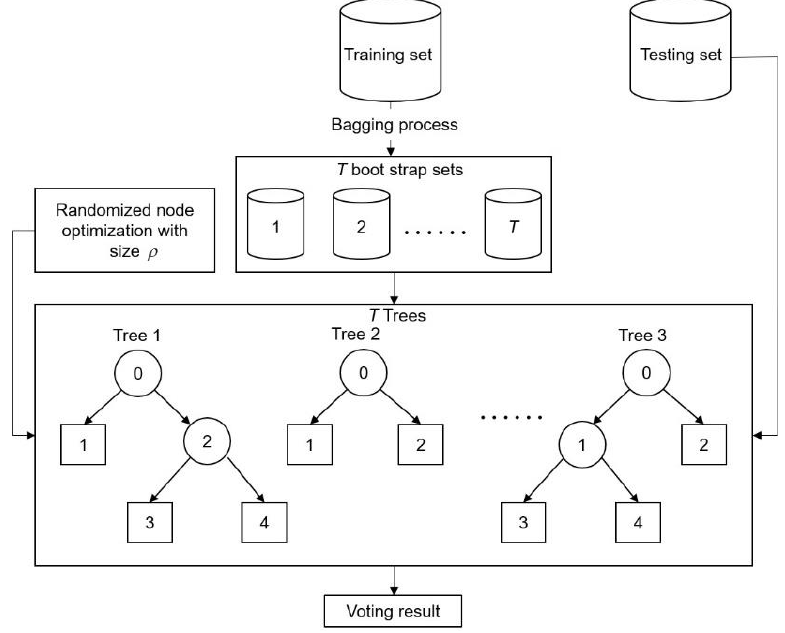
Figure 5. Construction process for the RF (Random Forest) classifier.